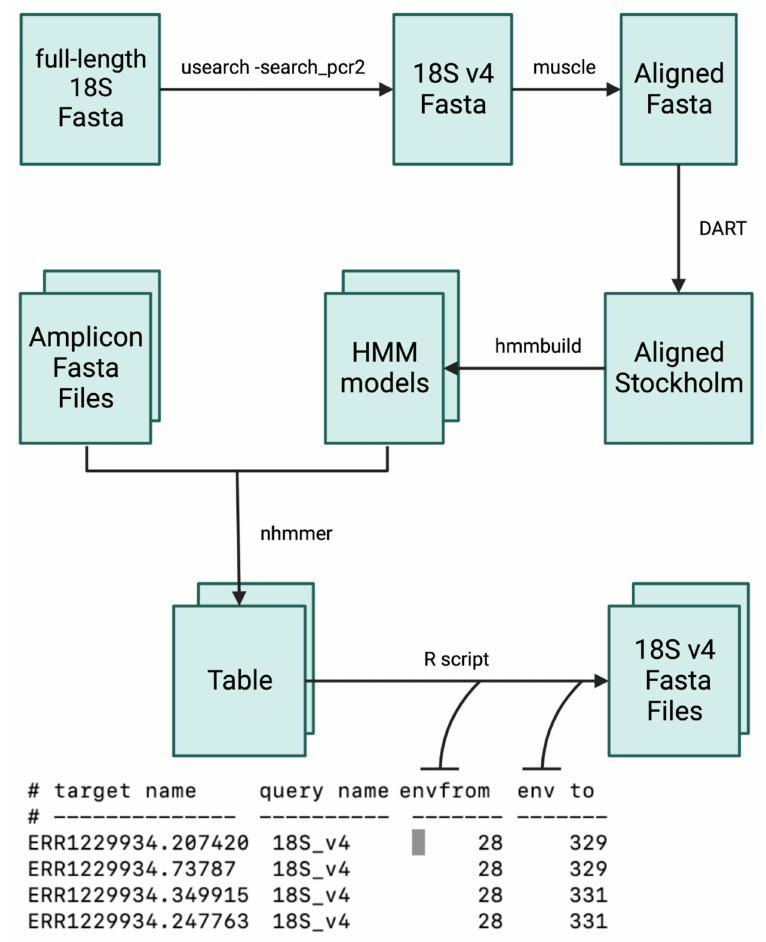
Figure 1. Information scale correction